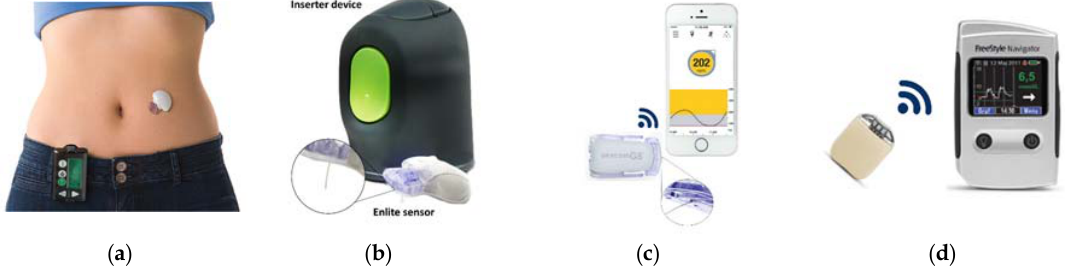
Figure 2. Examples of minimally-invasive CGM systems based on electrochemical sensing technique: ( a ) A patient wearing a sensor (taken from [27]); ( b ) Medtronic Enlite sensor with dedicated inserter device (taken from [28]); ( c ) Dexcom G5 Mobile with Share technology (taken from [29]); ( d ) Abbott FreeStyle Navigator II. (taken from [30]).